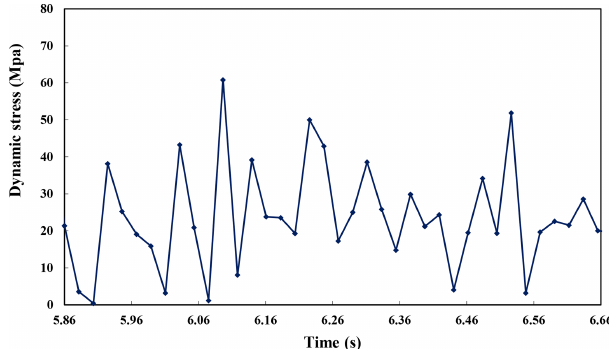
Figure 8. Curve of dynamic stress over time of each node at rotary speed is 140rmin − 1